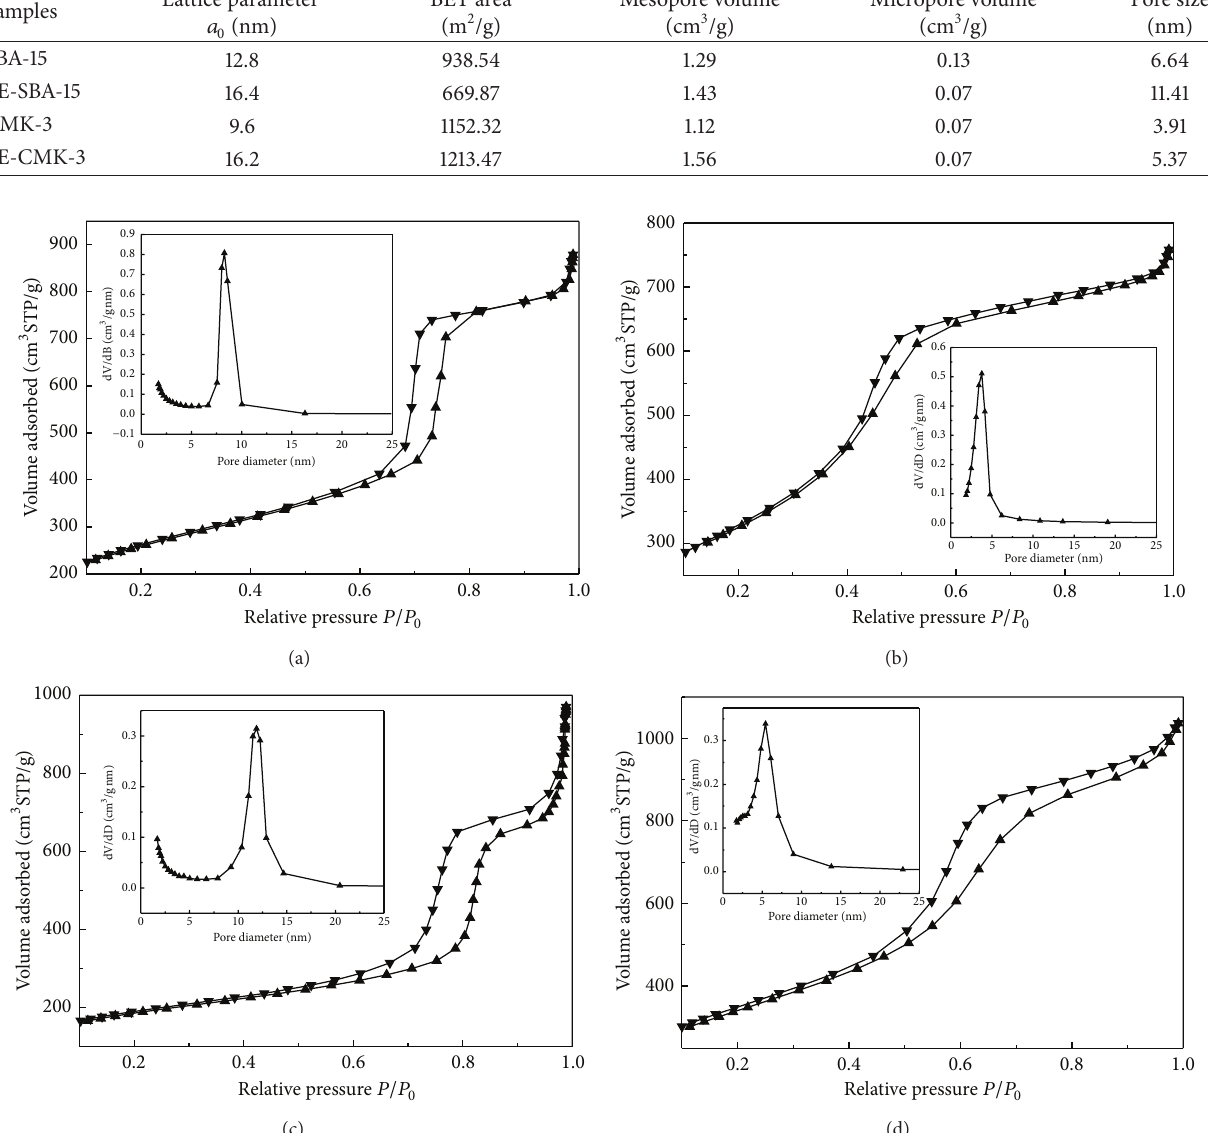
Figure 2: N 2 adsorption-desorption isotherms and pore size distribution of (a) SBA-15, (b) CMK-3, (c) PE-SBA-15, and (d) PE-CMK-3.